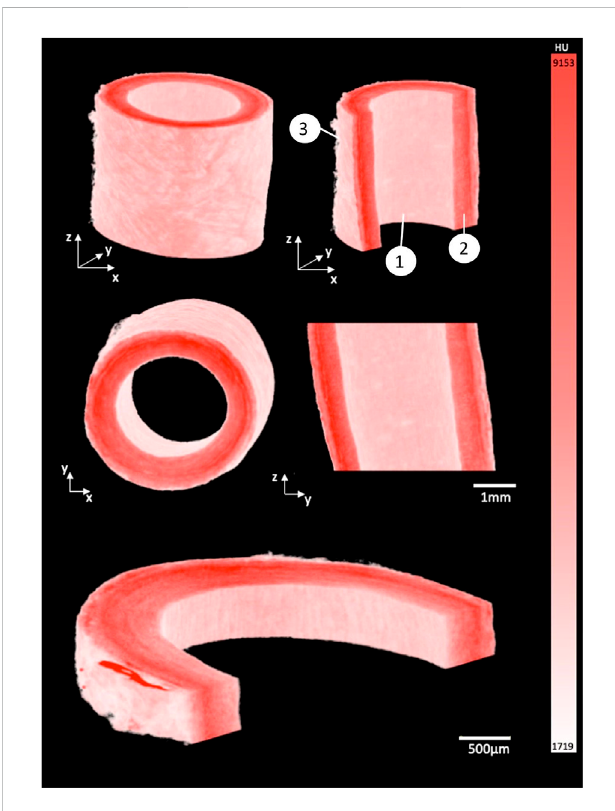
FIGURE 2 3D render of porcine carotid artery stained for 15 h using 1% PTA. Each image shows different cross-sectional views highlighting the capability to visualize the multiple layers of the vessel wall: (1) Intimal layer, (2) Medial layer, and (3) Adventitial